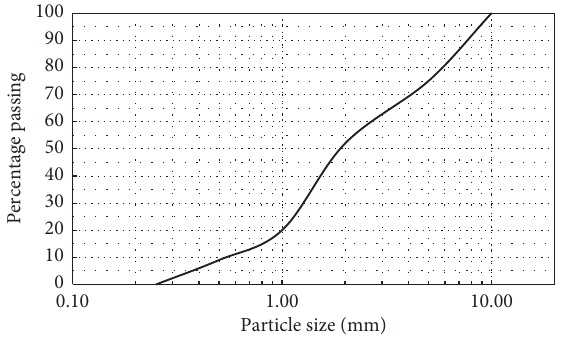
Figure 1: Particle size distribution of the soil. Table 1: Properties of the geogrid used in the tests. Rib width (mm) Tensile strength (kN/m) Mesh size (mm) Cross Longitudinal Transverse Longitudinal 20.0 × 20.0